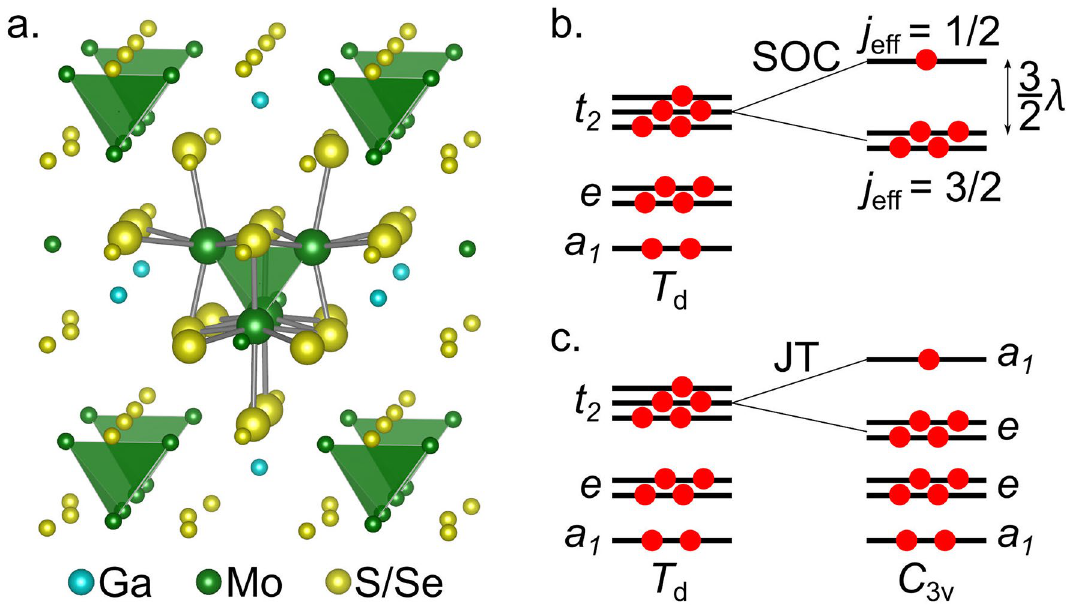
Figure 1. GaMo 4 X 8 cluster model and molecular orbital schemes. ( a ) GaMo 4 S 8 /GaMo 4 Se 8 cluster model. Mo 4 tetrahedra are shown in green. Small atomic spheres indicate capped effective core potentials (cECPs). (Ga: blue, Mo: green, S/Se: yellow). ( b ) Molecular-orbital diagram for the Mo 4 cluster in high-temperature, cubic T d point group with spin–orbit coupling (SOC) and low-temperature, rhombohedral C 3v symmetry as a result of Jahn– Teller (JT)